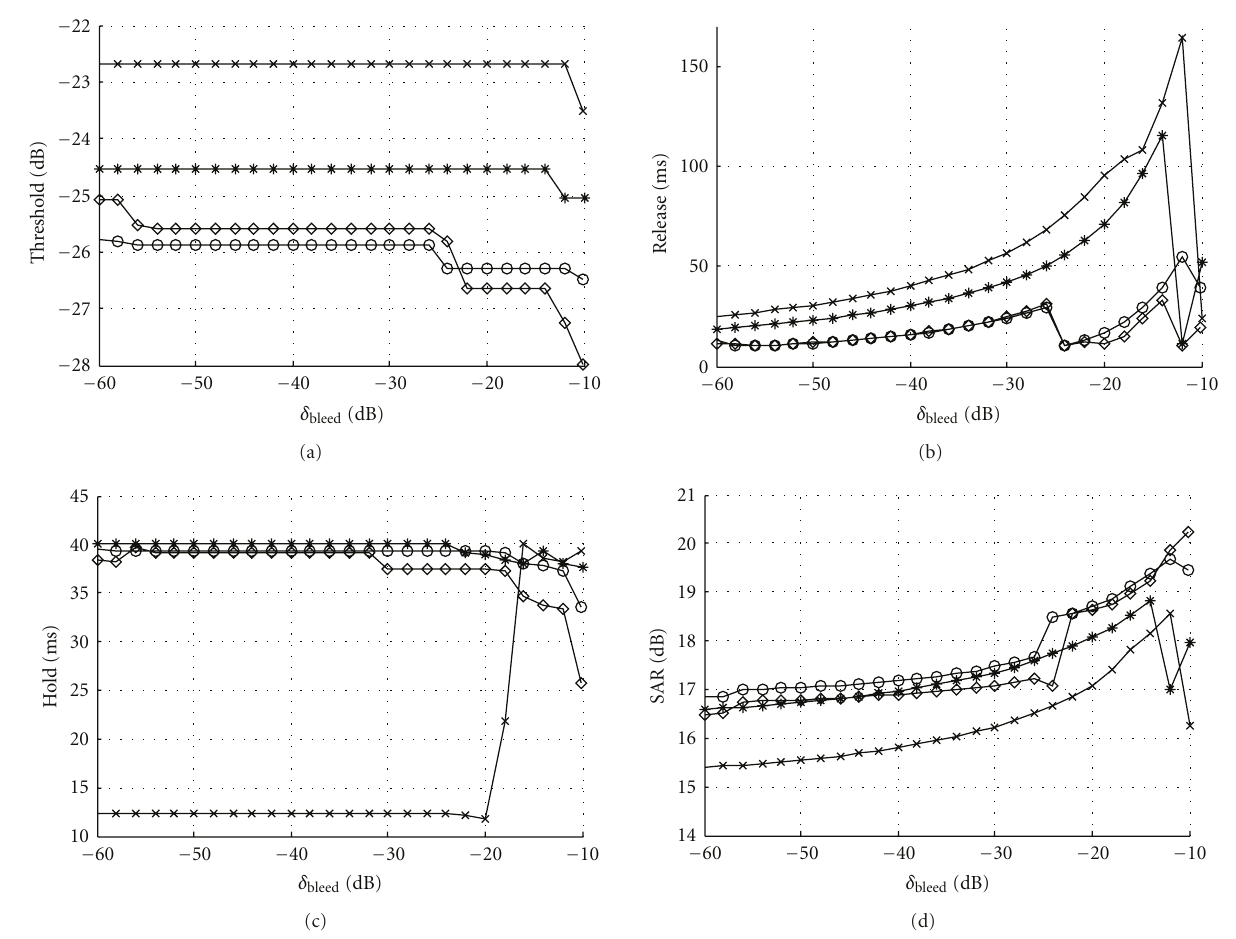
Figure 5: Noise gate parameter values after optimization, plotted against the required reduction in bleed ( δ bleed as defined in Figure 3). Part (a) shows threshold, (b) shows release time, (c) shows hold time and (d) shows SAR. Results are plotted for a number of relative bleed strengths identified by, (cid:5) : +0dB, (cid:6) : +2dB, ∗ : +4dB, × :